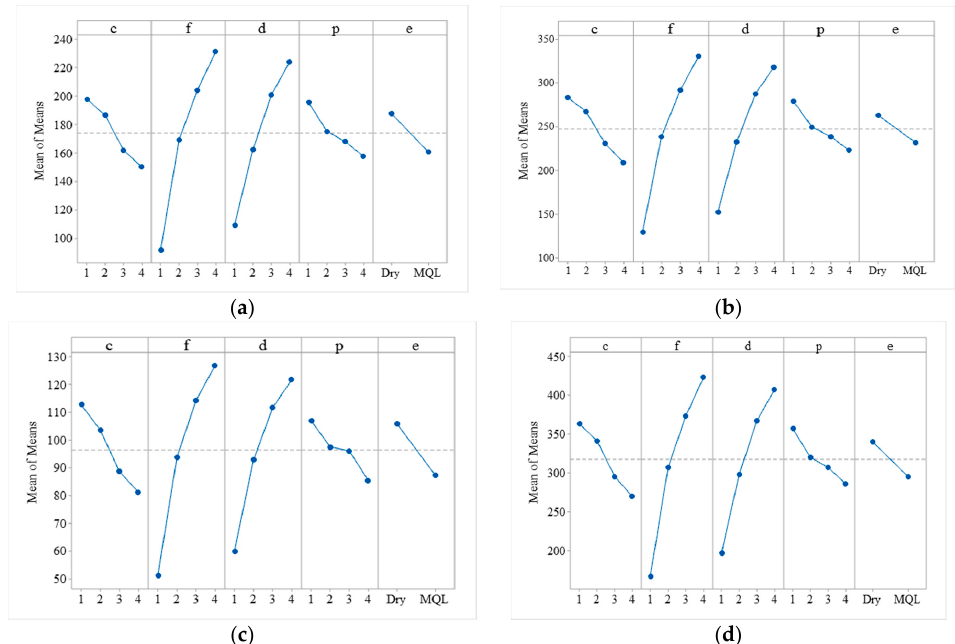
Figure 7. Main effect plot for means of components of cutting forces. ( a ) feed force ( b ) tangential force ( c ) radial force ( d ) resultant force.